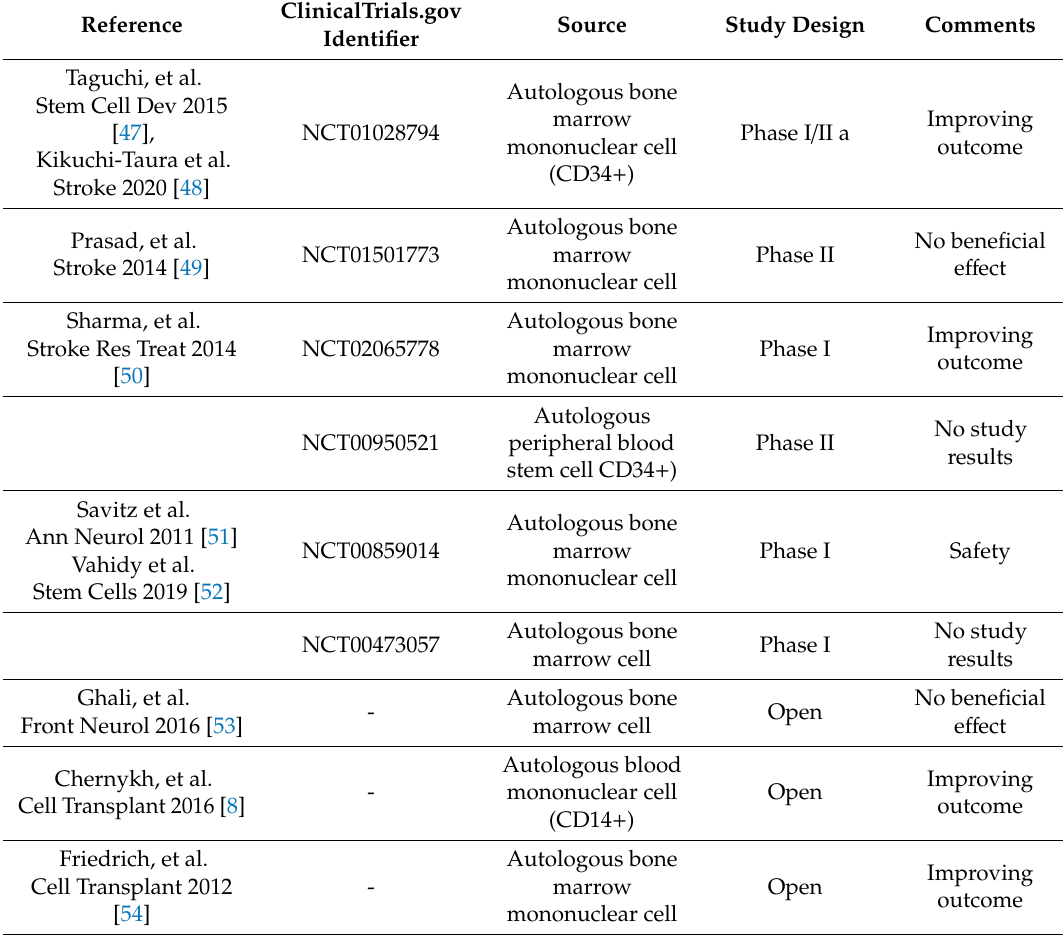
Table 2. List of bone marrow- and peripheral blood-derived mononuclear cell therapies under clinical